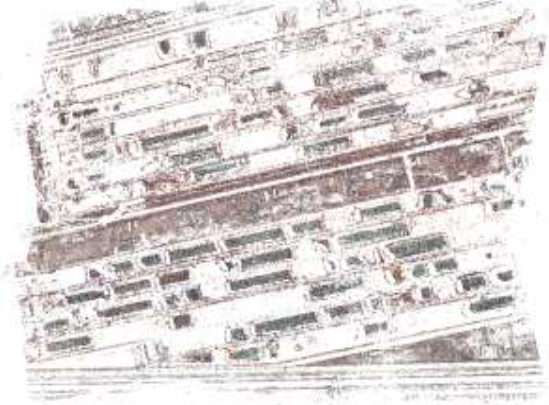
Fig. 9. Sparse scene geometry of the study area recovered with traversal matching